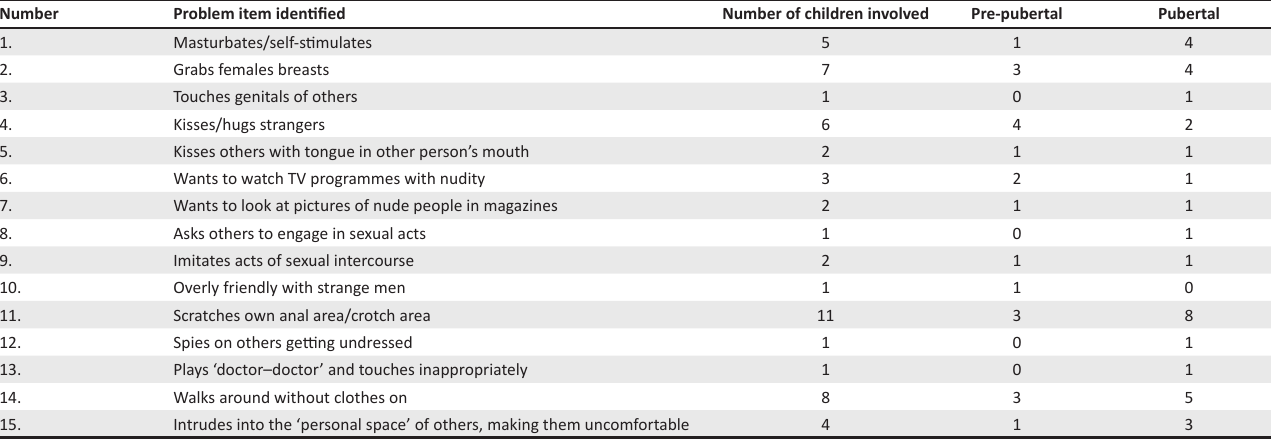
TABLE 4: Problem item identified regarding reported sexual